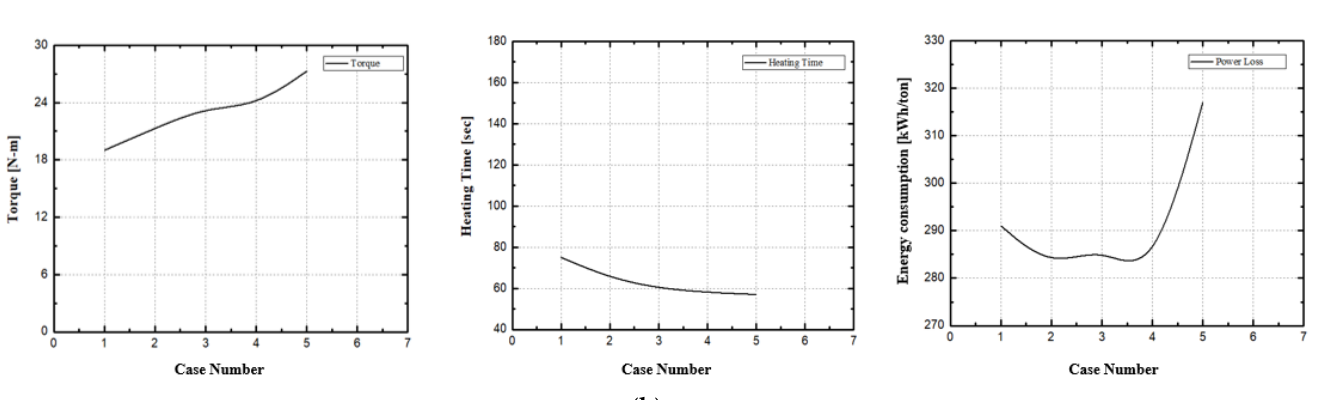
Figure 16. Analysis results according to magnet arrangement clearance: ( a ) electromagnetic field analysis result; ( b ) torque, heating time, and energy consumption result graph. Table 8. A nalysis results of normal direction model.